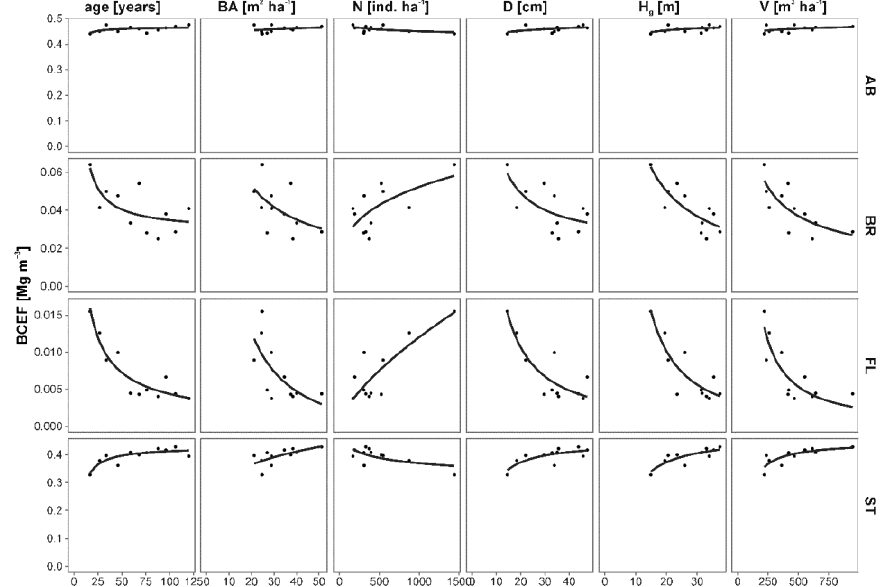
Figure 5. Relationships between forest stand characteristics and biomass conversion and expansion factors (BCEFs) for biomass components: total aboveground (AB), branches (BR), foliage (FL) and stem (ST). Parameters of non-linear regression models are presented in Table 5.